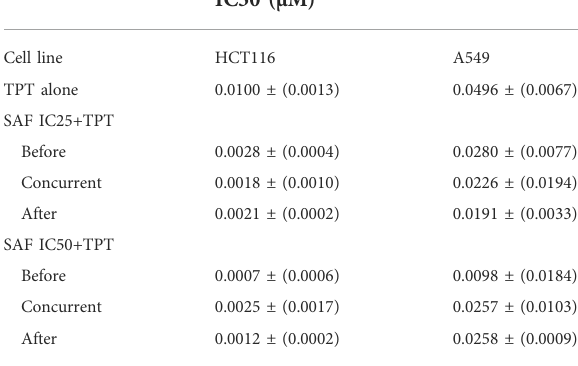
TABLE 1 IC50 values after treatment of HCT116 and A549 cell lines with TPT and TPT + SAF at different sequences. IC25 ( μ M): the concentration of the drug necessary to produce 25% inhibition of cell growth. IC50 ( μ M): the concentration of the drug necessary to produce 50% inhibition of cell growth. Represented data are means ± SEM of at least three independent experiments.